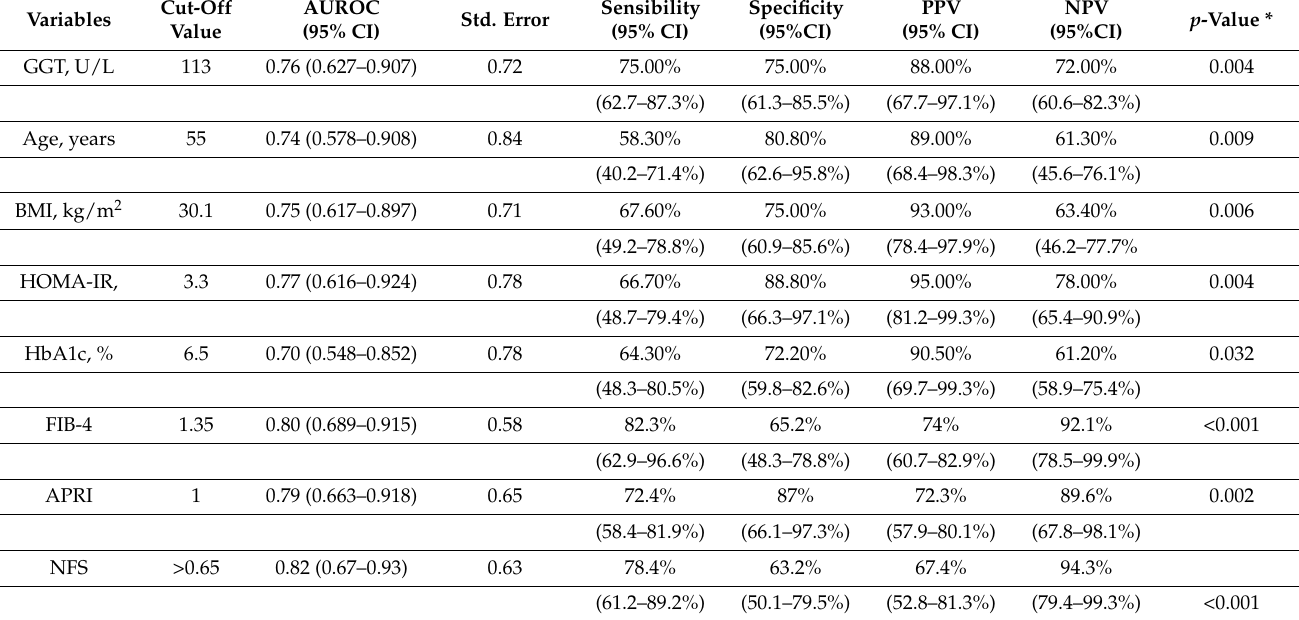
Table 3. Diagnostic performances of different parameters in predicting severe liver fibrosis.